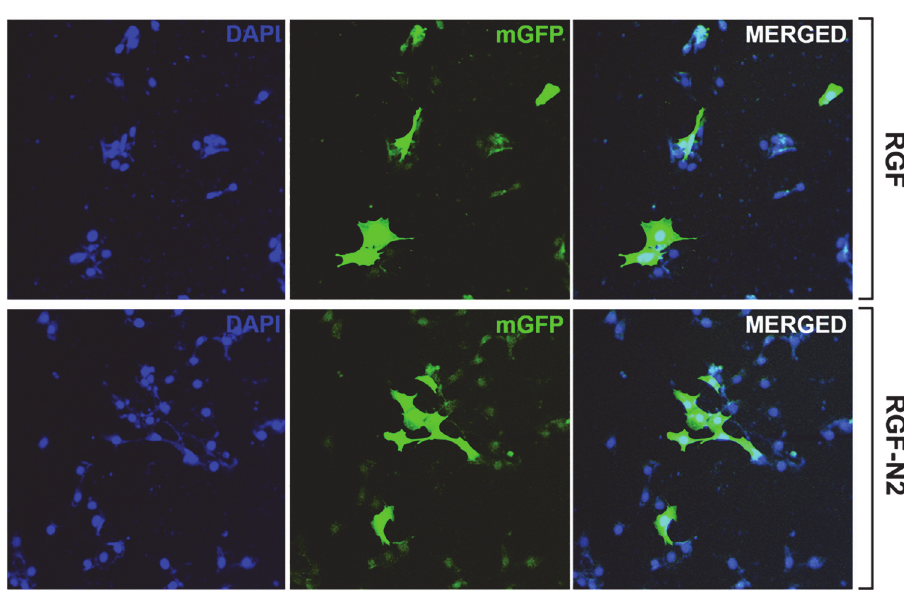
Fig 4. Plasmid DNA transfer in immortalized rat portal fibroblastic RGF and RGF-N2 cell lines by immunofluorescence. RGF and RGF-N2 cells were transfected with an expression vector encoding monomeric GFP protein cDNA using Fugene6 transfection reagent. Transfected cells were then fixed and counterstained with DAPI dye, before confocal microscopy imaging. Both cell lines exhibit green fluorescence signal, indicative of recombinant GFP protein expression. 200X magnification